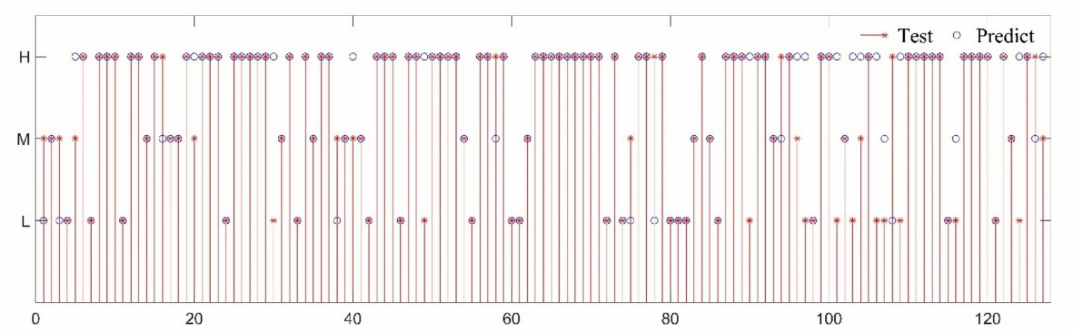
Figure 13. Test labels and predicted labels by